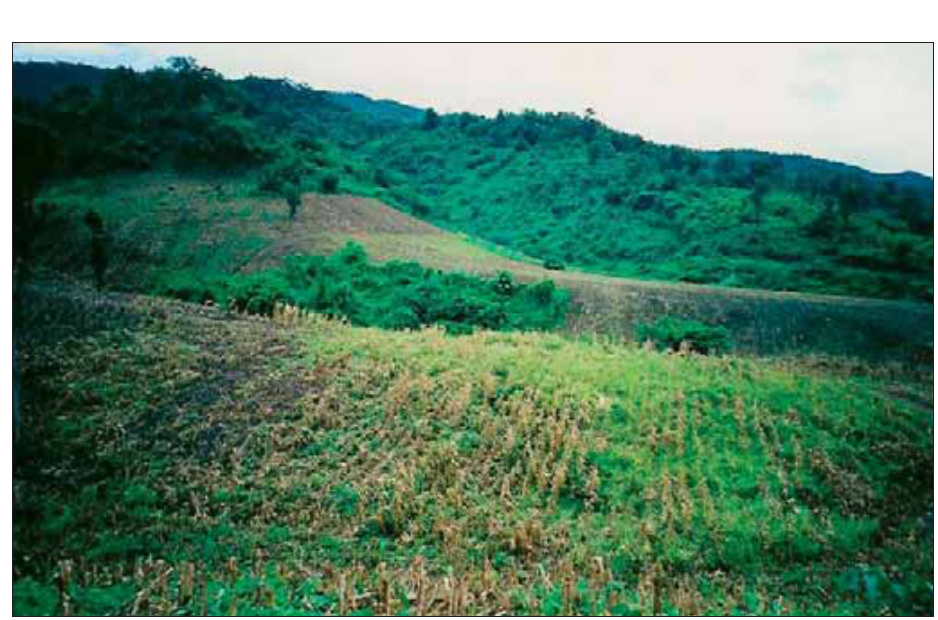
Fig. 10. Low angle fault scarp on surface of Late Quaternary alluvial fan, Thung Chang Segment, Pua Fault.